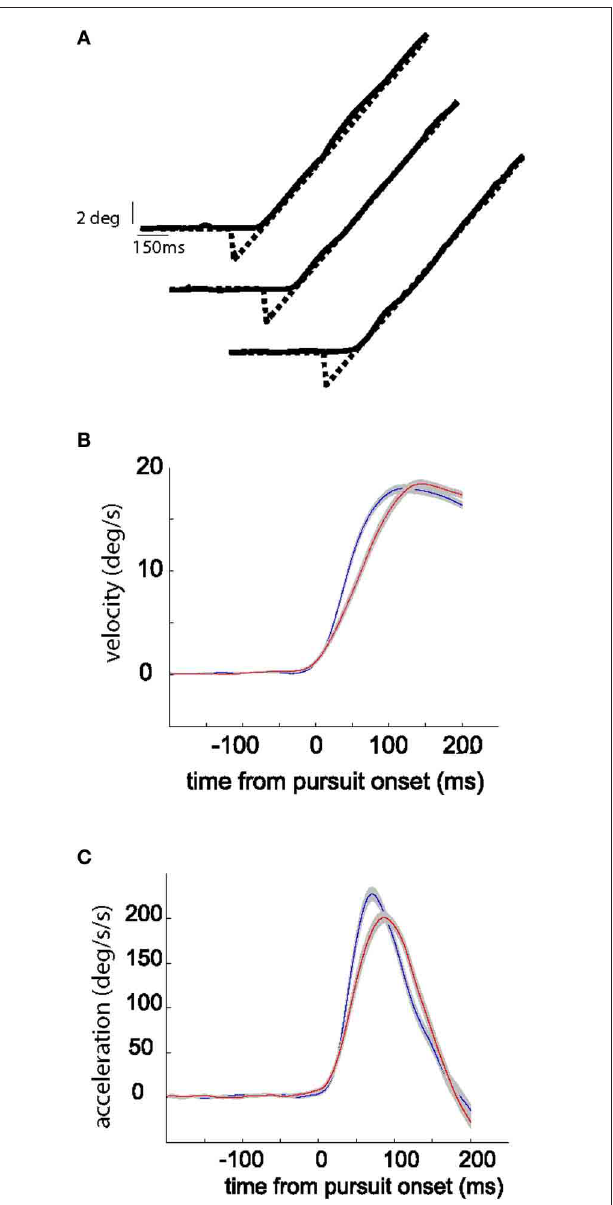
FIGURE 10 | Top panel shows exemplary target and eye position traces collected in the beginning, in the middle, and at the end of the session during SPEM resilience (A). Middle panel shows the average eye velocity in the first quarter (blue) and last quarter (red) of trials during a typical SPEM resilience session (B) . The lower panel shows the corresponding average eye acceleration traces (C) . The gray shadow around the red and blue traces signifies the standard